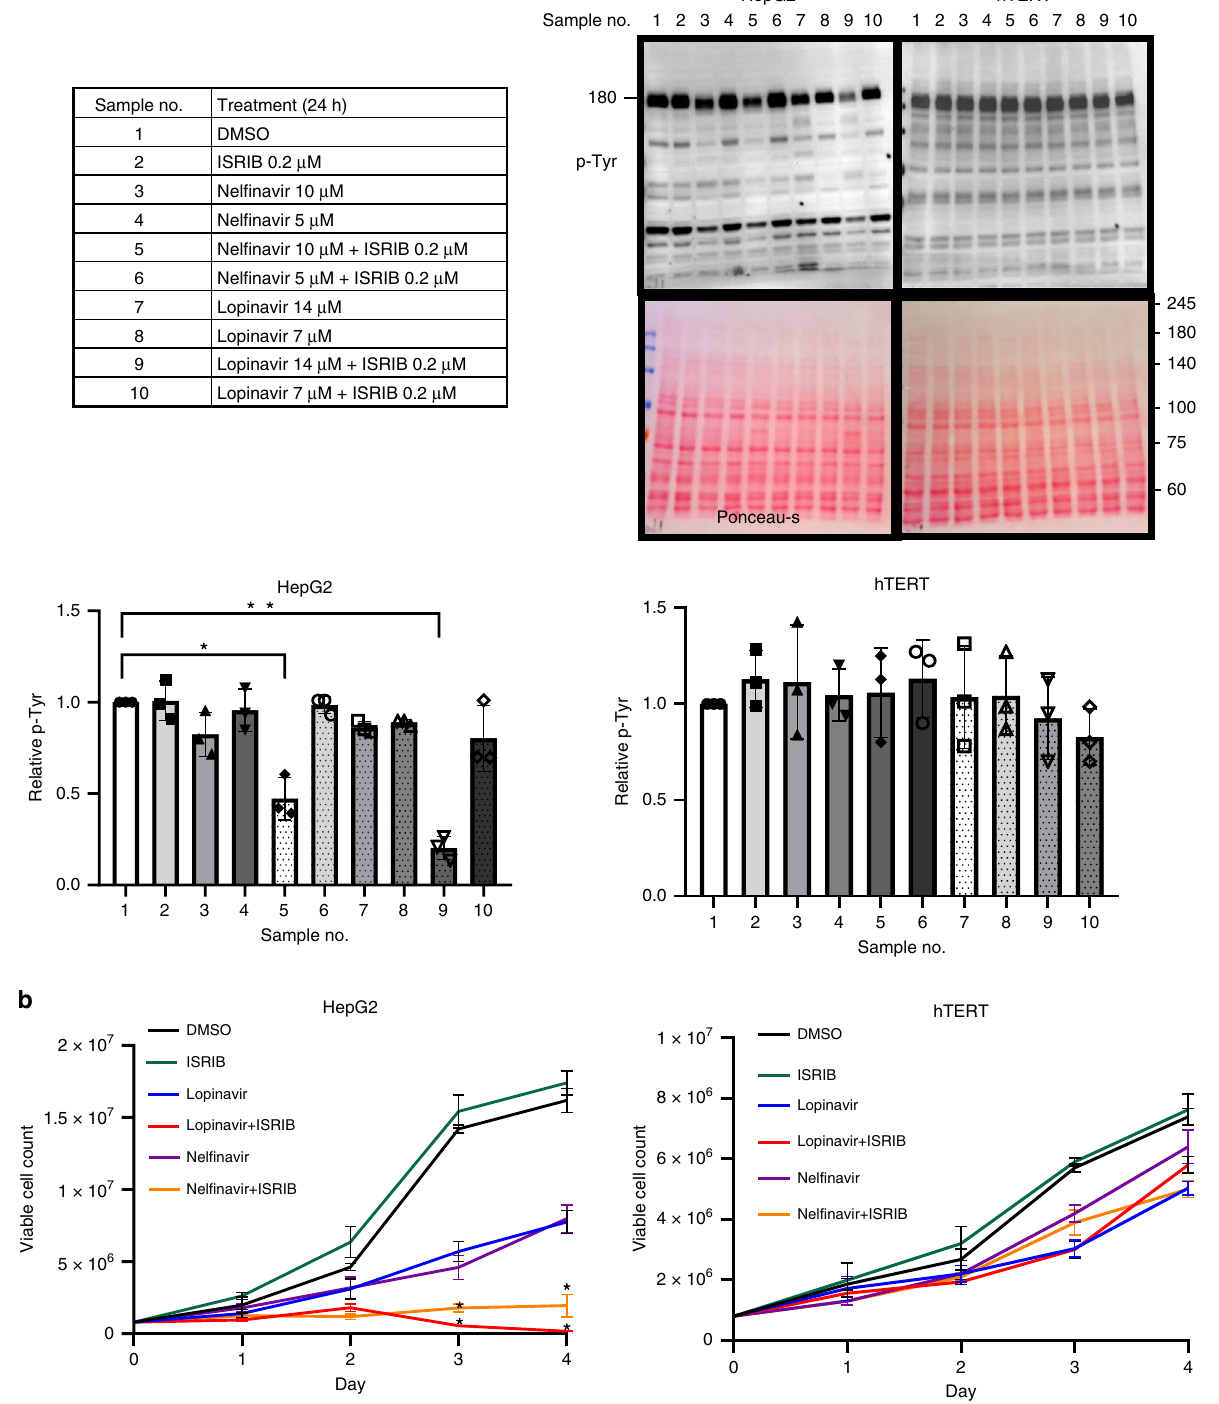
Fig. 5 The combination between lopinavir or nel fi navir with ISRIB elicits sERr, reduces total P-Tyr levels and compromises growth of HepG2, less of hTERT cells. a Immunoblotting for P-Tyr and ponceau-s staining of HepG2 cells and of hTERT treated with DMSO, nel fi navir, lopinavir, and ISRIB as speci fi ed in the table (left). Quanti fi cation of total P-Tyr relative to ponceau-s is shown in bar graphs (right) for both experiments. Average of three independent experiments ± SD. * p > 0.05, ** p < 0.01, Kruskal – Wallis one-way analysis of variance. b Monitoring of proliferation evaluation of HepG2 and hTERT cells treated with DMSO, ISRIB (0.2 μ M), nel fi navir (14 μ M) (top-left), and lopinavir (14 μ M) (top-right) alone or in combination. Data are shown as viable cell count (VCC) vs. time (days) conducted in triplicates for each treatment. Error bars represent S.E.M. Statistical signi fi cance was calculated for each combined treatment relative to drug only. * p > 0.05 were calculated using Student ’ s t test